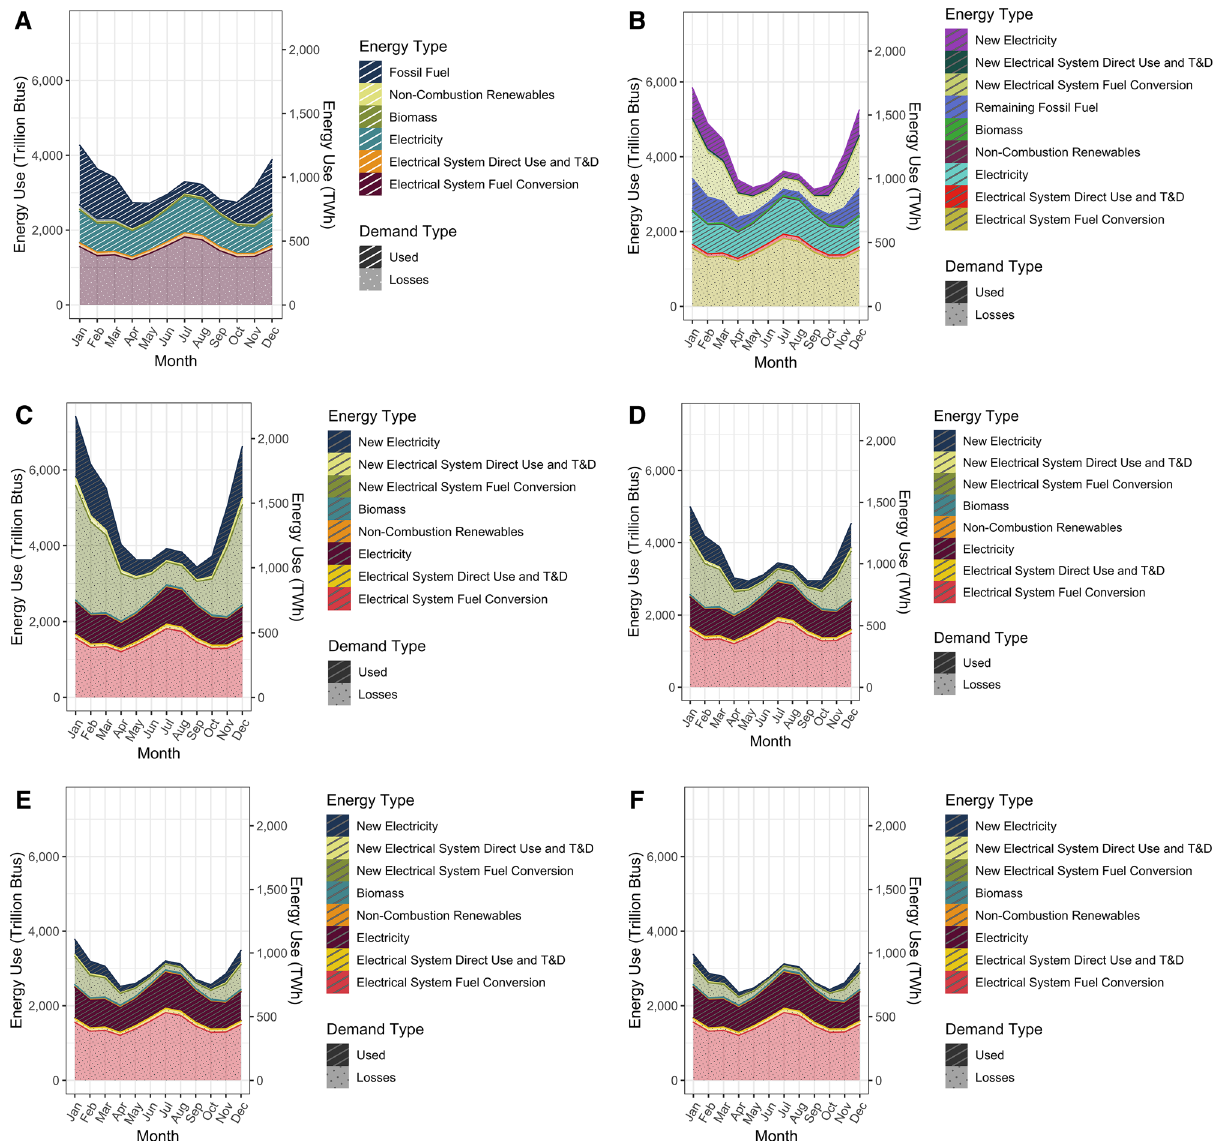
Figure 3. The “Falcon Curve”—Monthly average building total energy consumption from March 2010 to February 2020, and changes to building energy demand under different scenarios of building electrification with the current electrical grid. ( A ) current—all buildings’ energy demand. B-E are scenarios representing electrification of fossil energy use at ( B ) 50% conversion using technologies with a coefficient of performance (COP) of 1; ( C ) 100% conversion using technologies with a COP of 1; ( D ) 100% conversion using technologies with a COP of 2; ( E ) 100% conversion using technologies with a COP of 4; and ( F ) 100% conversion using technologies with a COP of